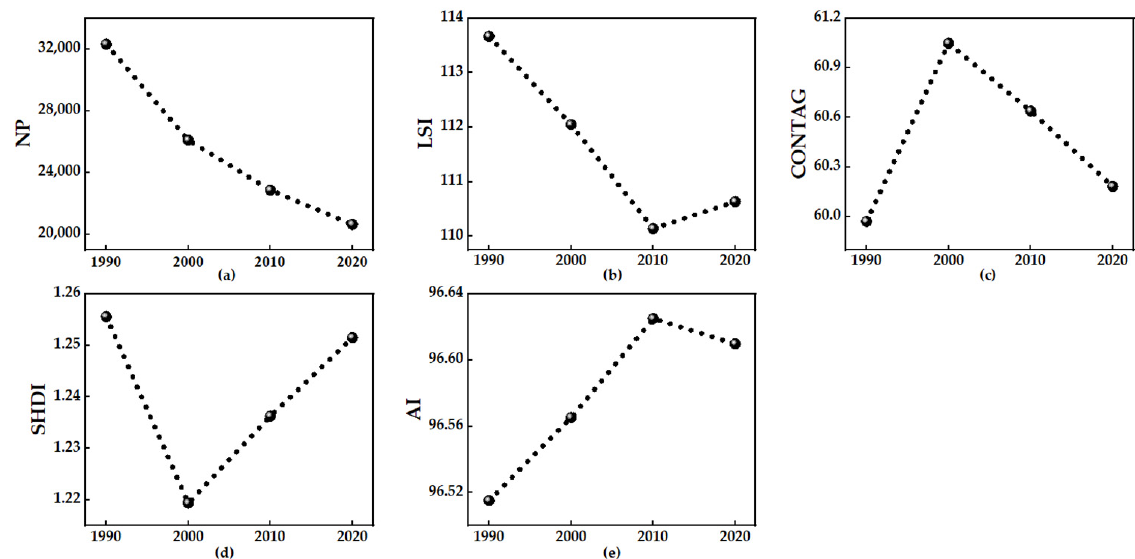
Figure 7. Changes of landscape metrics ( a ) Number of Patches (NP), ( b ) Landscape Shape Index (LSI), ( c ) Contagion index (CONTAG), ( d ) Shannon’s Diversity Index (SHDI), and ( e ) Aggregation Index (AI) at the landscape level from 1990 to 2020.